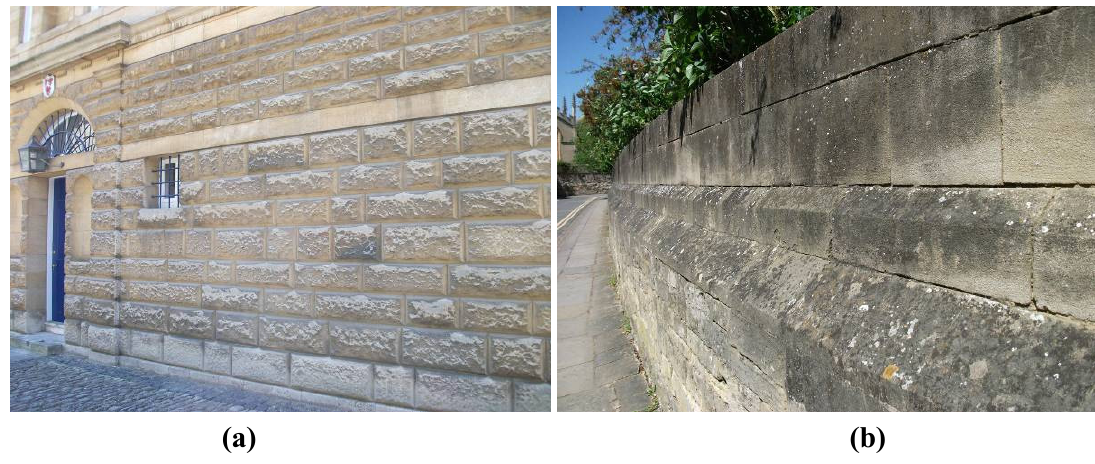
Figure 9. Scale-sensitive extending features, including ( a ) blisters and ( b ) lichens.